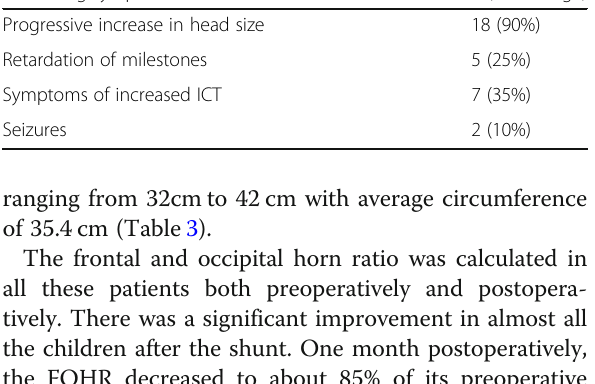
Table 3 Fronto-occipital horn ratio, an anatomical and radiological assessment